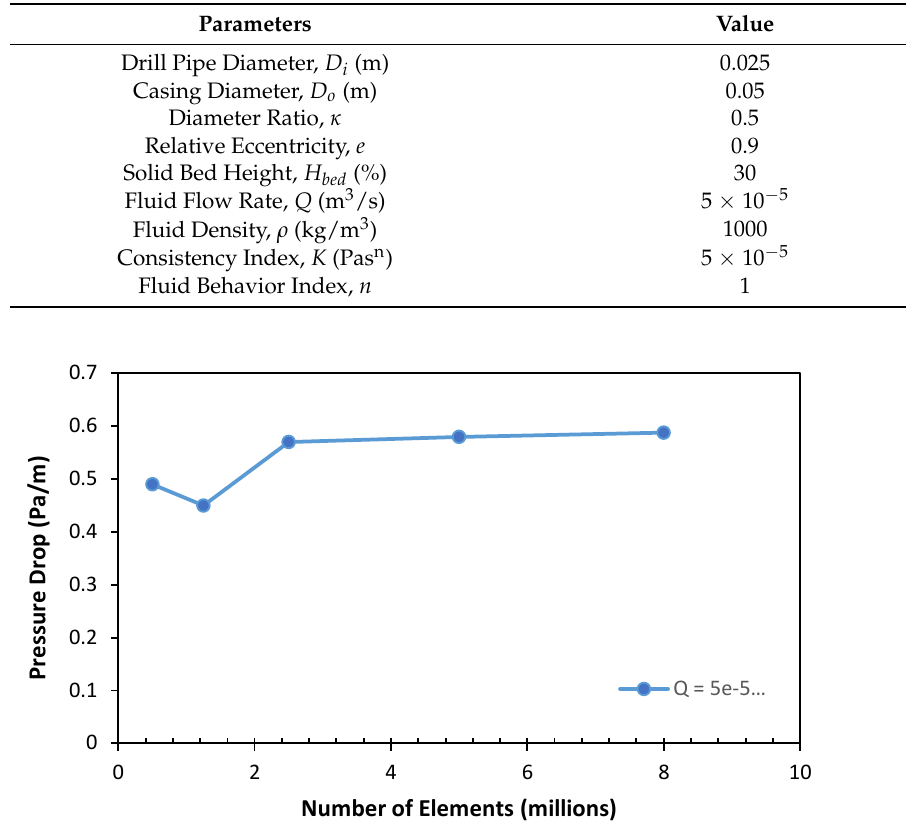
Figure 3. Grid independent study for various numbers of grids [25].